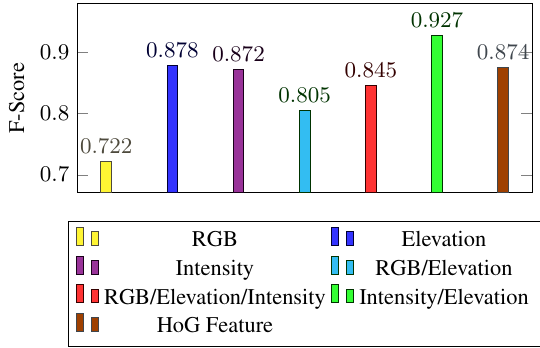
Figure 13. F-Scores for the training results derived by different data of the Large-CNN.